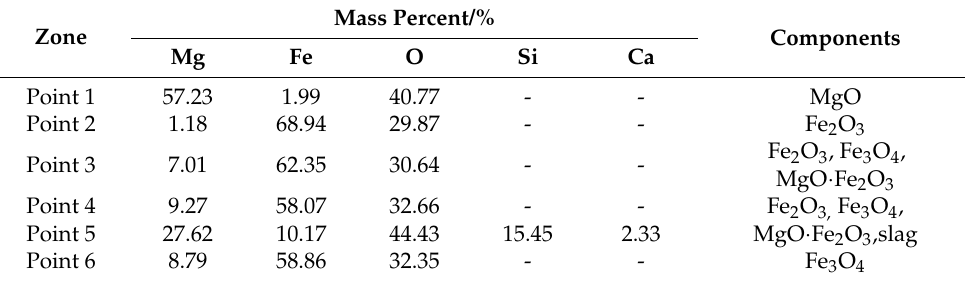
Table 6. EDS analysis of Fe 2 O 3 -MgO sample after reduction.